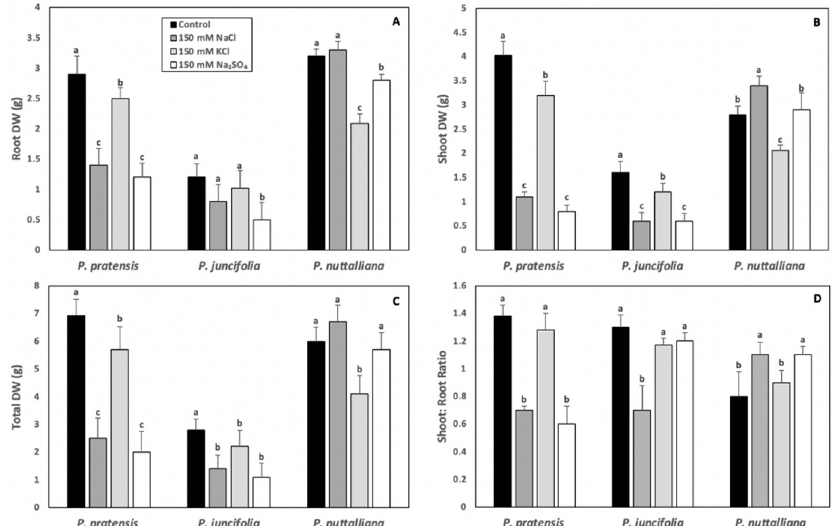
Figure 1. Root ( A ), shoot ( B ), and total dry weights (DW) ( C ) and shoot to root DW ratios ( D ) in Poa pratensis , Poa juncifolia and Puccinellia nuttalliana treated for 10 days with 150 mM NaCl, 150 mM KCl, 150 mM Na 2 SO 4 and in control (untreated) plants. Different letters or numbers above the bars indicate significant differences ( p ≤ 0.05) between treatments within each species as determined by the Tukey’s test. Means ( n = 6) and SE are shown.